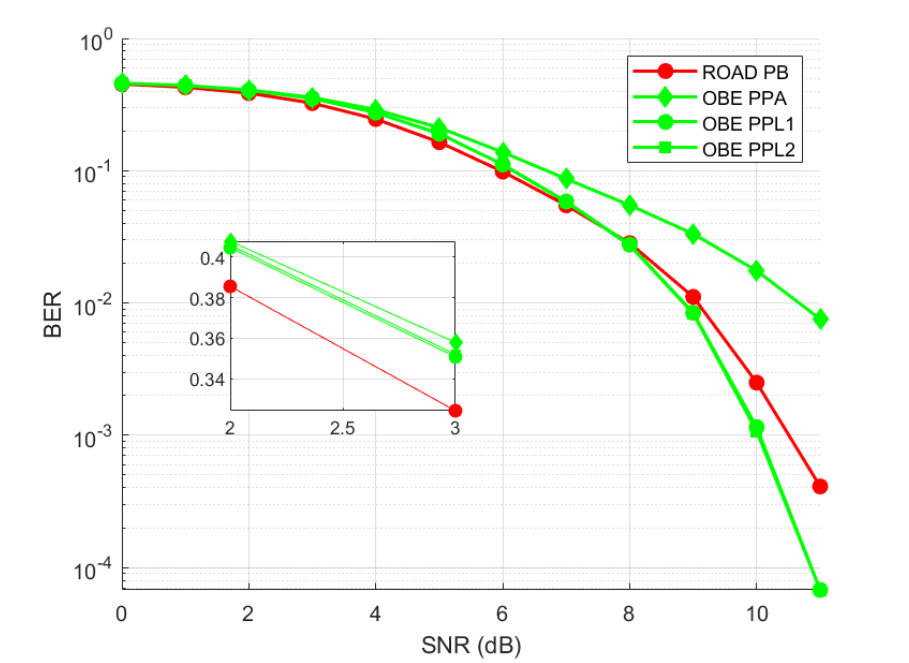
Figure 26. Performance of ROADPB vs. OBE enhanced pulse peak